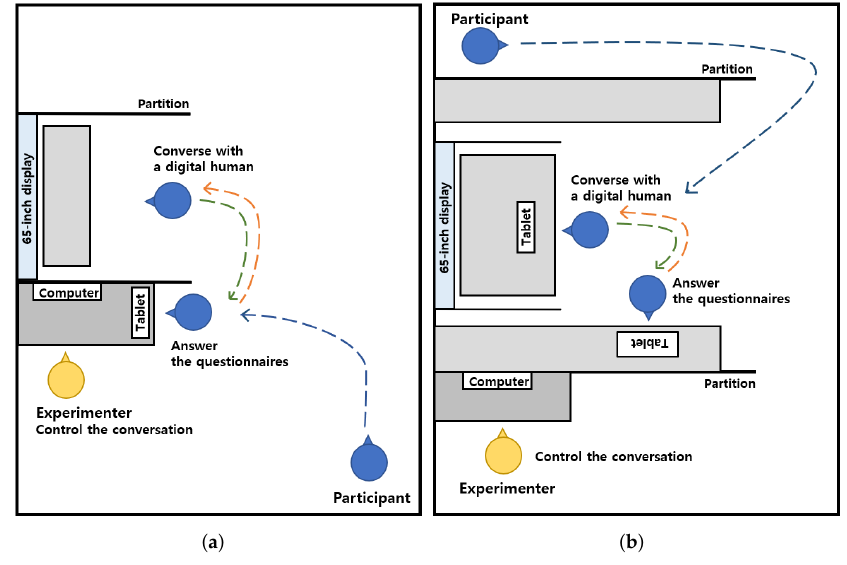
Figure 2. The schematics of the experimental space for ( a ) Study 1 and ( b ) Study